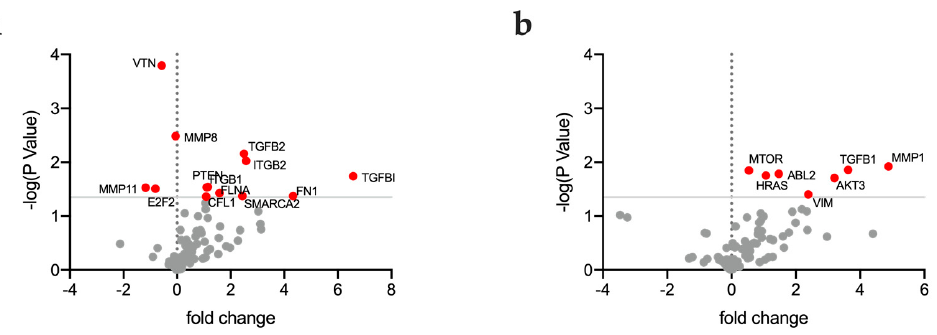
Figure 3 . Volcano plots representing differential gene expression in cell lines with unimodal vs. bimodal stiffness distribution ( a ) and low vs. high invasiveness score ( b ). Red dots indicate genes with a significant different expression between groups.